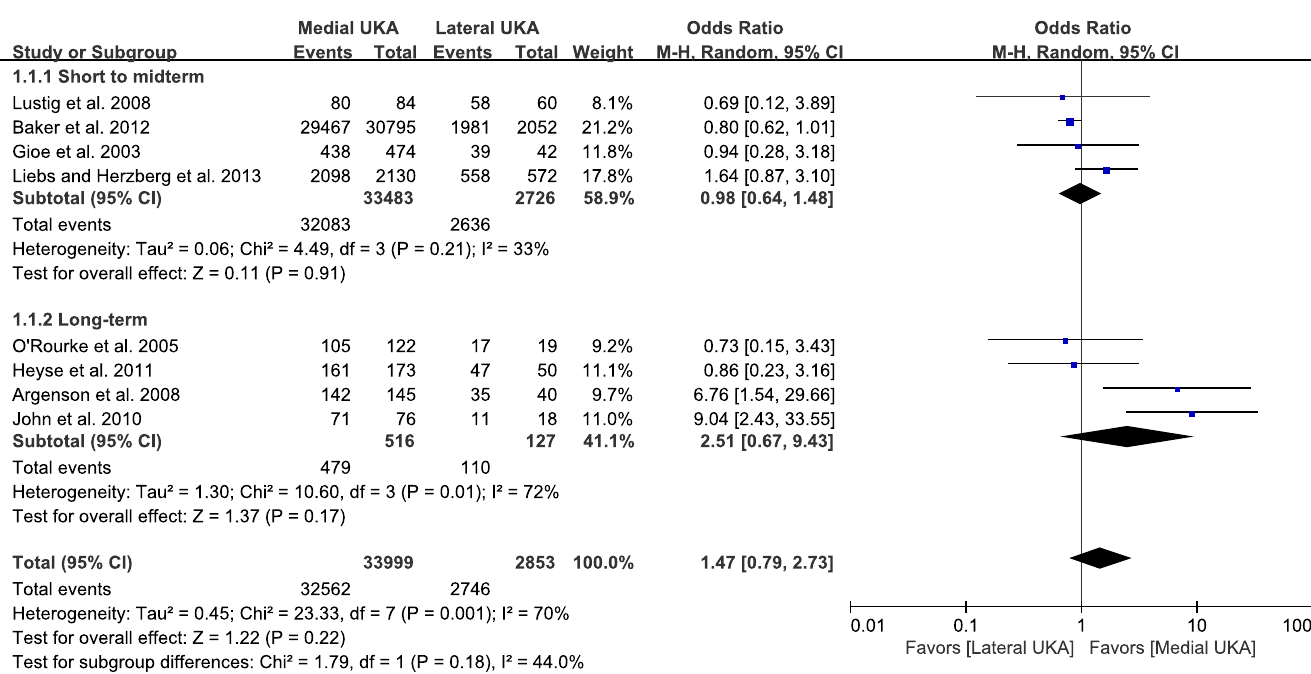
short- to mid-term survival (95.6% by the medial UKA and 94.6% by the lateral UKA) and long-term survival (92.8% by the medial UKA and 86.6% by the lateral UKA). The sensitivity